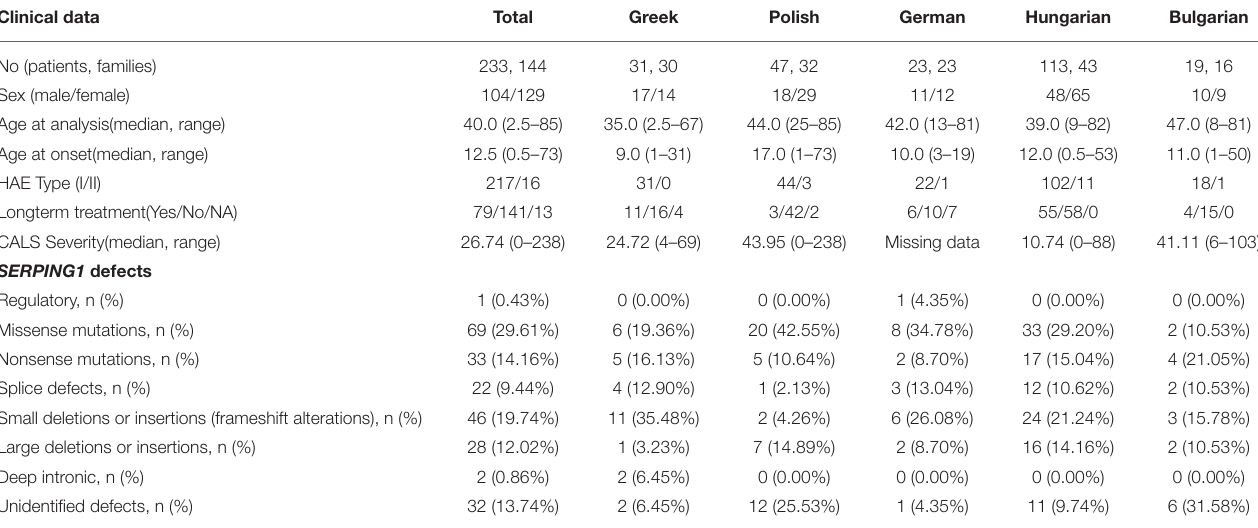
TABLE 1 | Demographic, clinical, and molecular data of the C1-INH-HAE patients. Clinical